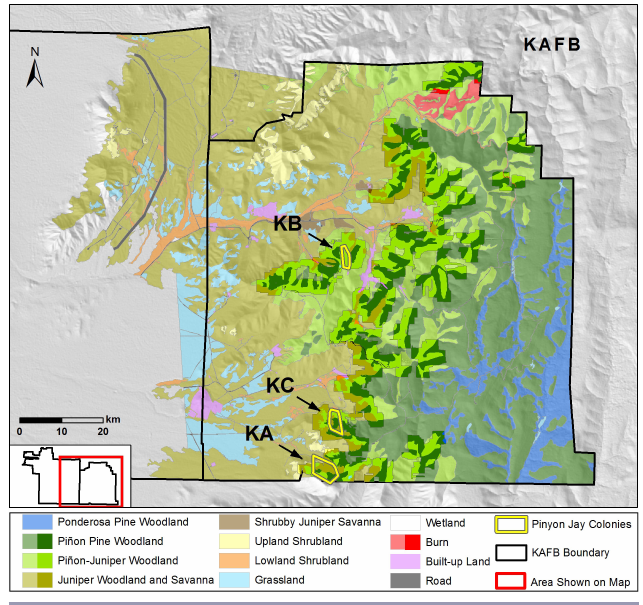
Fig. 5 . Kirtland Air Force Base Pinyon Jay ( Gymnorhinus cyanocephalus ) colony-scale predictive habitat model and nesting colonies. Colony model is shown in bright colors; other land